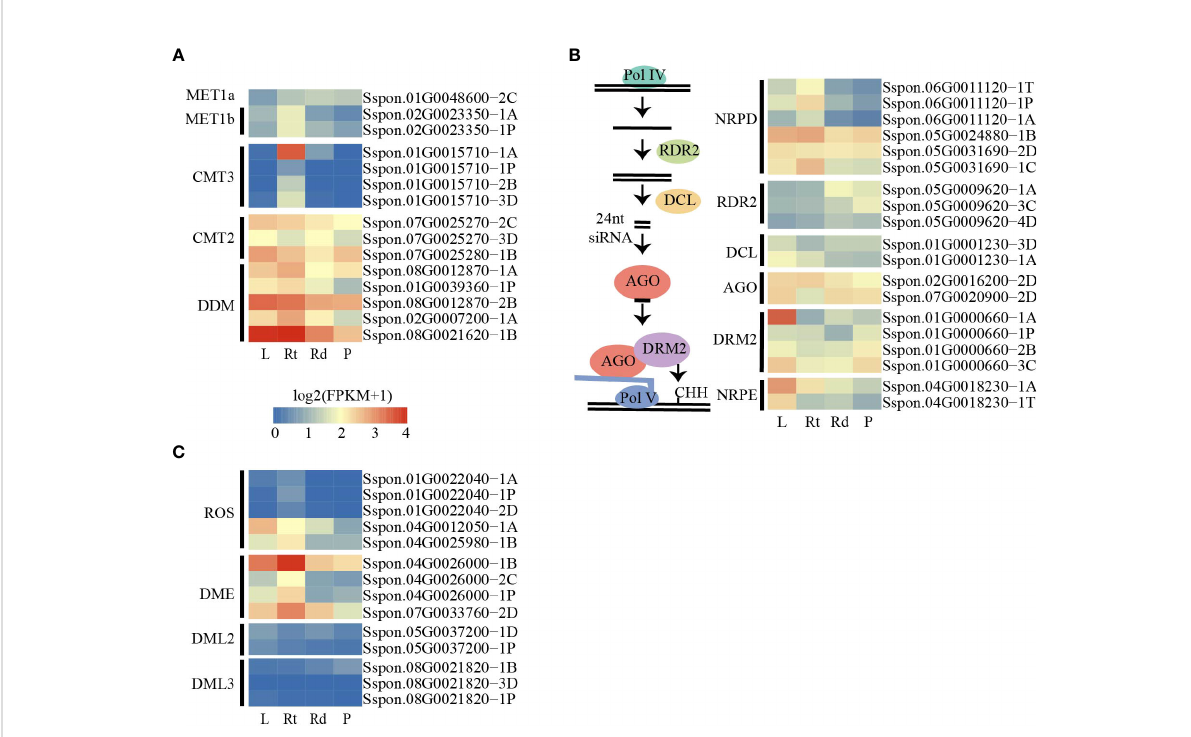
FIGURE 3 DNA methylated and demethylated genes are active in sugarcane tissues. (A) Heatmap showing the expression patterns of methylation-related genes among tissues. (B) Schematic diagram of the canonical RdDM pathway (left). Heatmap showing the expression patterns of canonical RdDM pathway genes among tissues. (C) Heatmap showing the expression patterns of demethylated genes. L, leaf; Rt, root; Rd, rind; P,